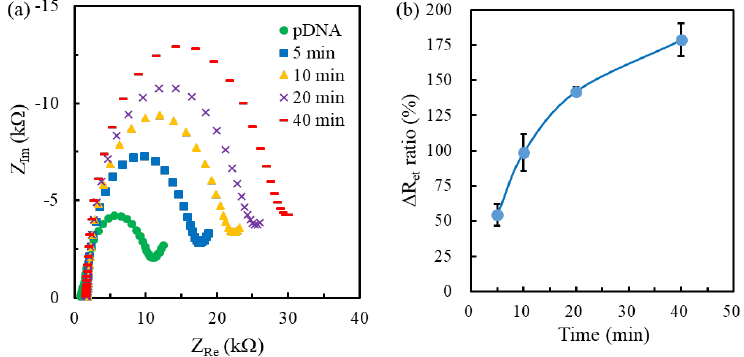
Figure 6. ( a ) Nyquist plots obtained at the pDNA/MHA(0.04 mM)/MCH(1 mM)/Au genosensors continuously hybridized with the extracted RNA fragments of 10 4 plaque forming units (PFU)/mL dengue virus (DENV1) for different length of times. ( b ) The corresponding time-lapse Δ R et ratio.